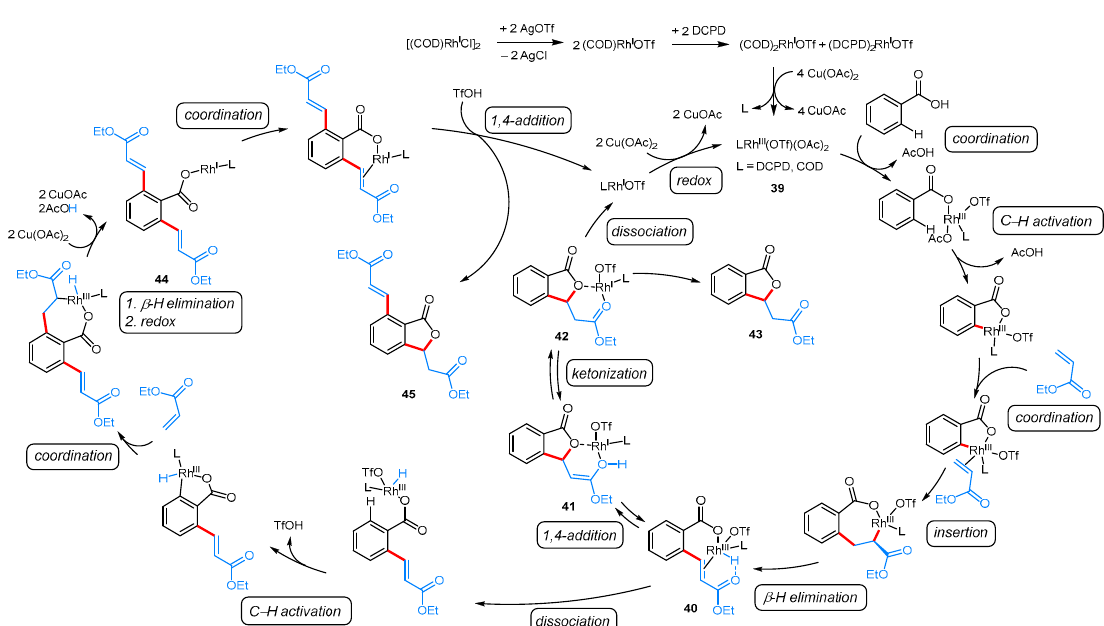
Scheme 25. Proposed mechanism for the Rh-catalyzed annulative coupling of benzoic acids and electrophilic alkenes in the presence of